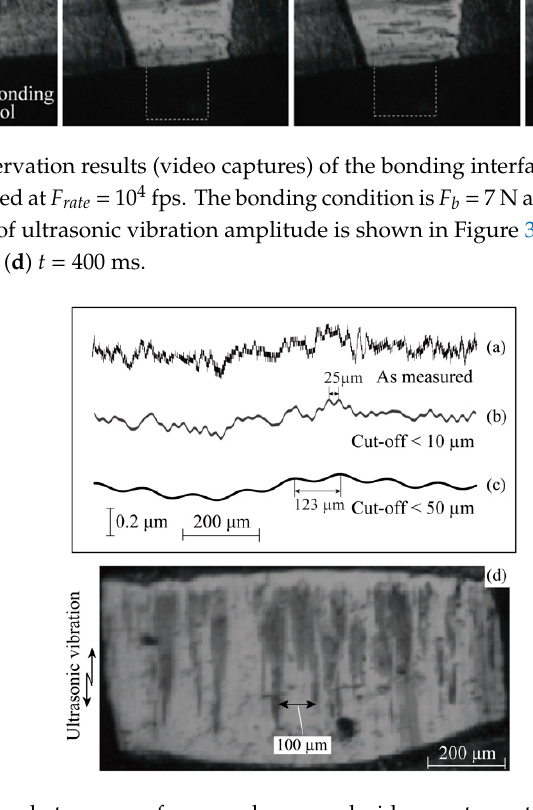
Figure 4. In-situ observation results (video captures) of the bonding interface between Al ribbon and silica substrate obtained at F rate = 10 4 fps. The bonding condition is F b = 7 N and P u = 3 W. Simultaneous measurement result of ultrasonic vibration amplitude is shown in Figure 3 (a–1): ( a ) t = 3 ms; ( b ) t = 50 ms; ( c ) t = 100 ms; ( d ) t = 400 ms.